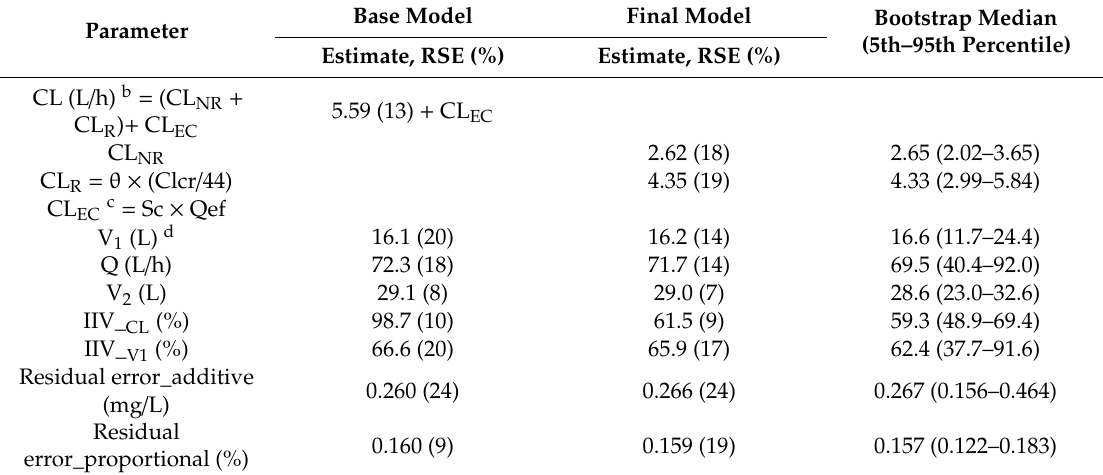
Table 3. Base and final population pharmacokinetic model estimates, shrinkage a values, and bootstrap results after short-term intravenous infusion.